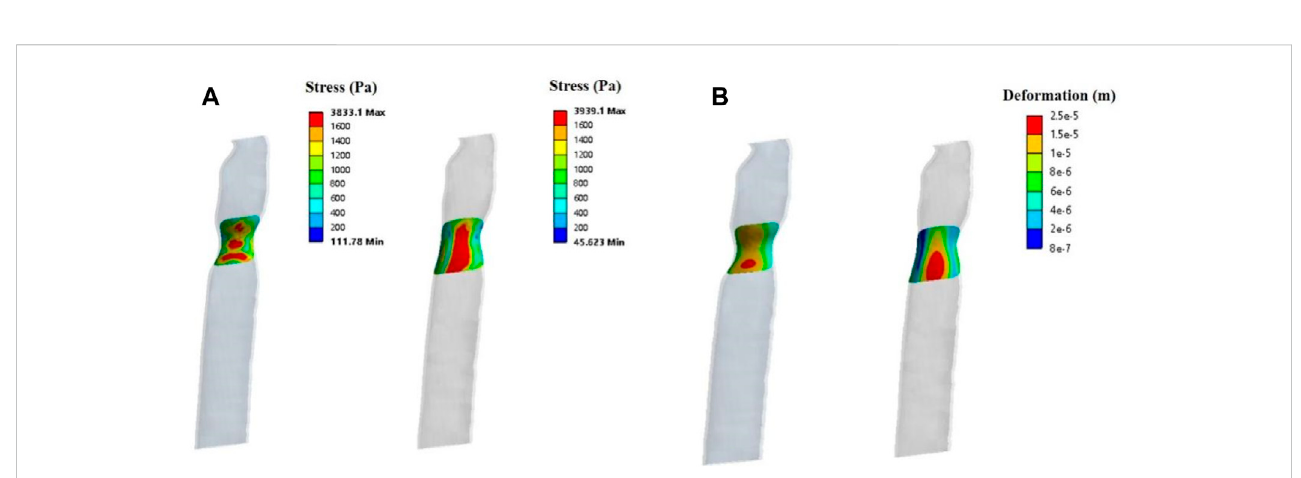
FIGURE 9 Solid simulations of the patch used for patient two. (A) . Contours of stress distribution on the patch. (B) . Contours of deformation on the